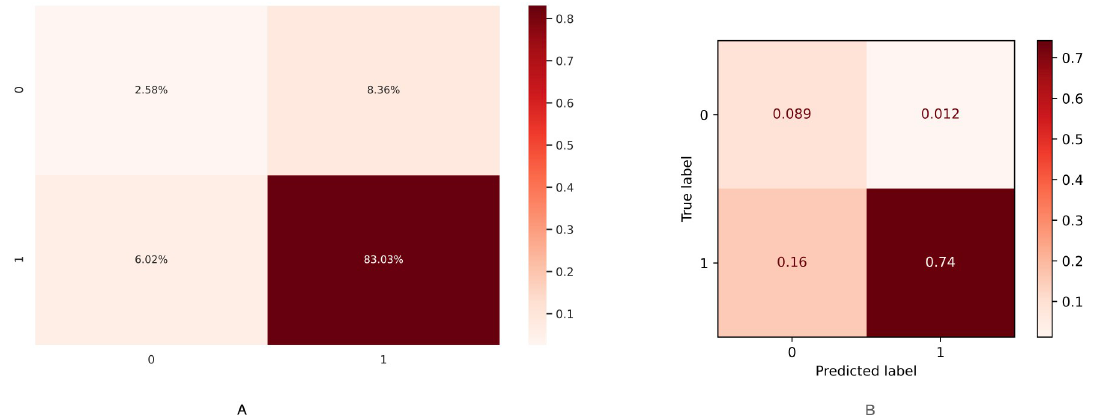
Fig 9. Improved prediction for the survival chance of a hospitalized patient. (A): Confusion matrix applying Naive Bayes with threshold δ = 0.45. (B): Confusion matrix using the SMOTE.